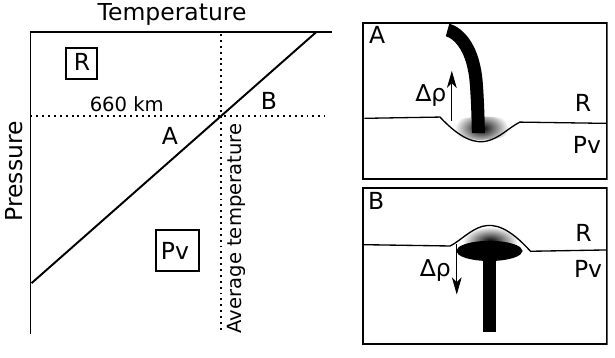
Fig. 1. Illustration of the layering mechanism modelled. The left hand side figure shows a schematic version of the phase diagram of the olivine component – Ringwoodite is stable in the upper left re- gion (labelled with R) while Perovskite and Ferropericlase is stable in the region (labelled with Pv) below the phase boundary line. The right hand side: Part (A) illustrates a cold downwelling impinging on the phase change. The fact that the material below the nominal depth of the phase change can still be the lighter Ringwoodite phase is shown by the letter A on the phase diagram to the left. As a re- sult, there is a downward deflection of the boundary, which leads to the lighter ringwoodite phase producing a buoyancy force and potentially layering. Part (B) on the right hand side illustrates that the same mechanism also can work in reverse, potentially leading to layering with hot